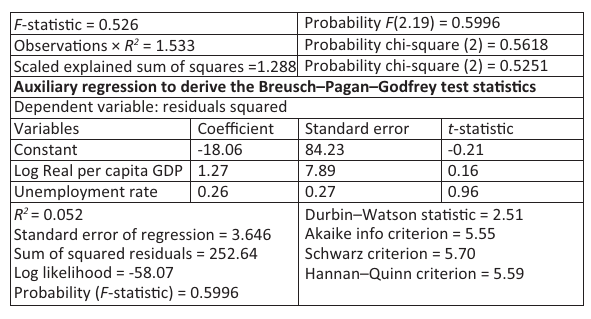
FIGURE 3-A1: Breusch–Pagan–Godfrey heteroscedasticity